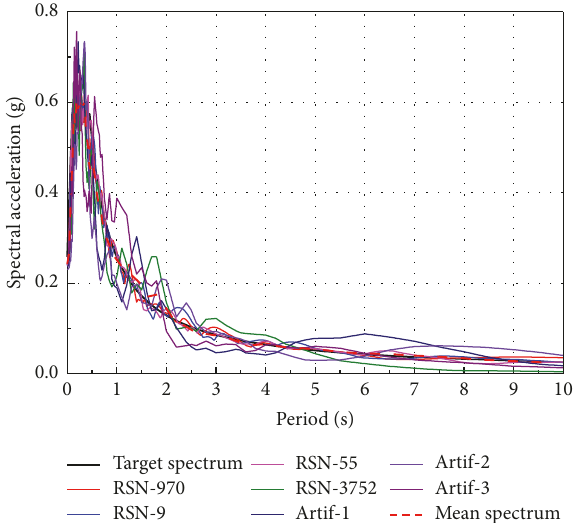
Figure 18: Target spectrum and the spectrum of selected ground motions.